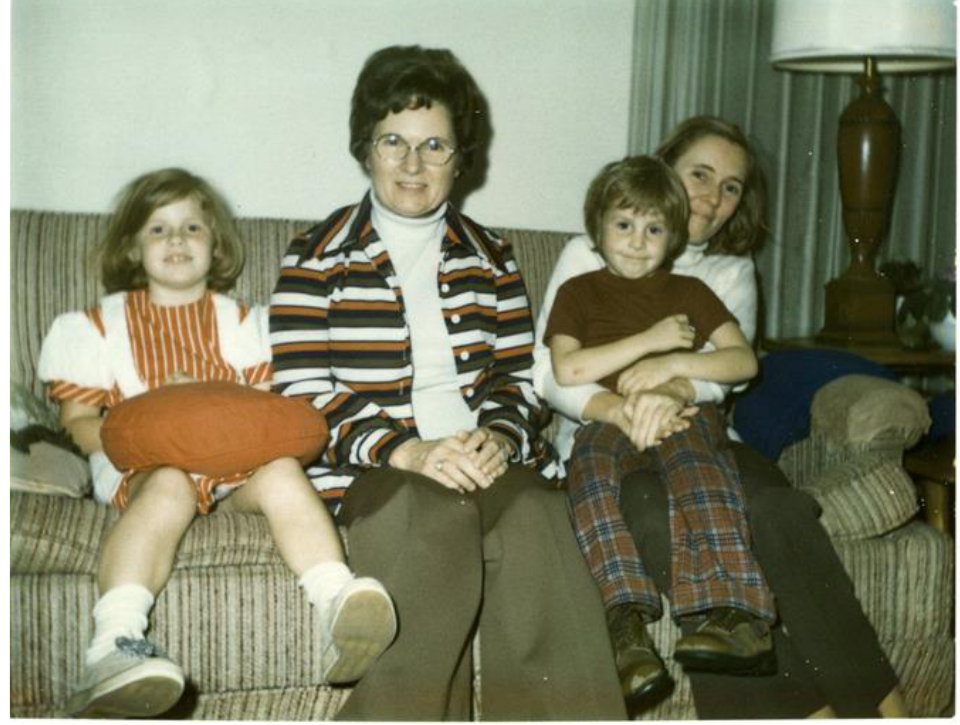
Figure 1: Family picture, 1973; from left to right: Sophie Sartain, Mimi Thornton, Bo Sartain, and Dona Thornton. Courtesy: Sophie